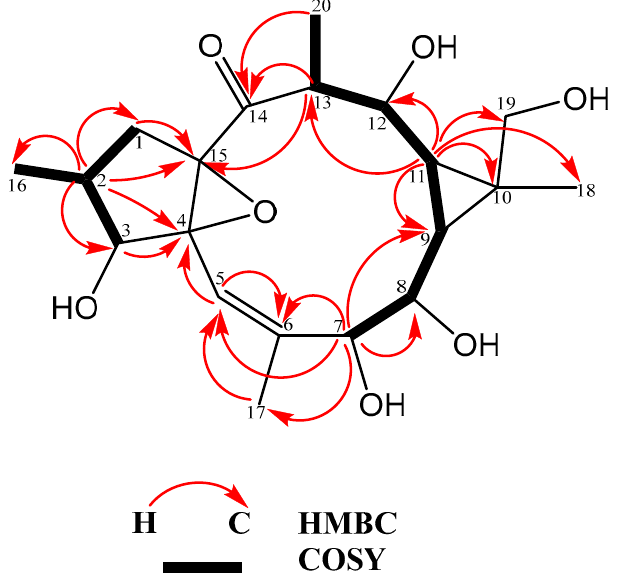
Figure 2. COSY and HMBC correlations of saudiarabicain F ( 2 ) isolated from E. saudiarabica.